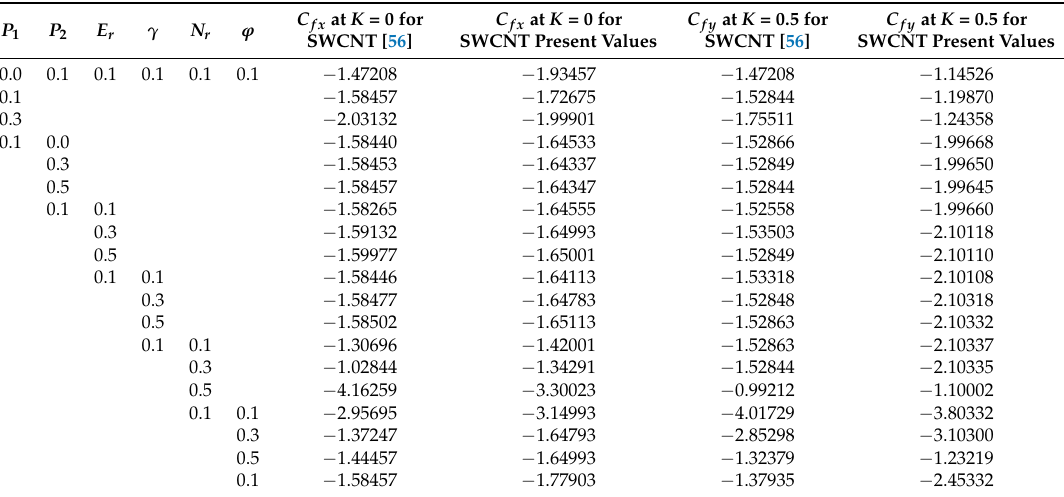
Table 5. Variation in skin-friction coefficient C fx and C fy for single-walled carbon nanotubes (SWCNTs) together with strong and weak concentrations K = 0 and K = 0.5 and the comparison with